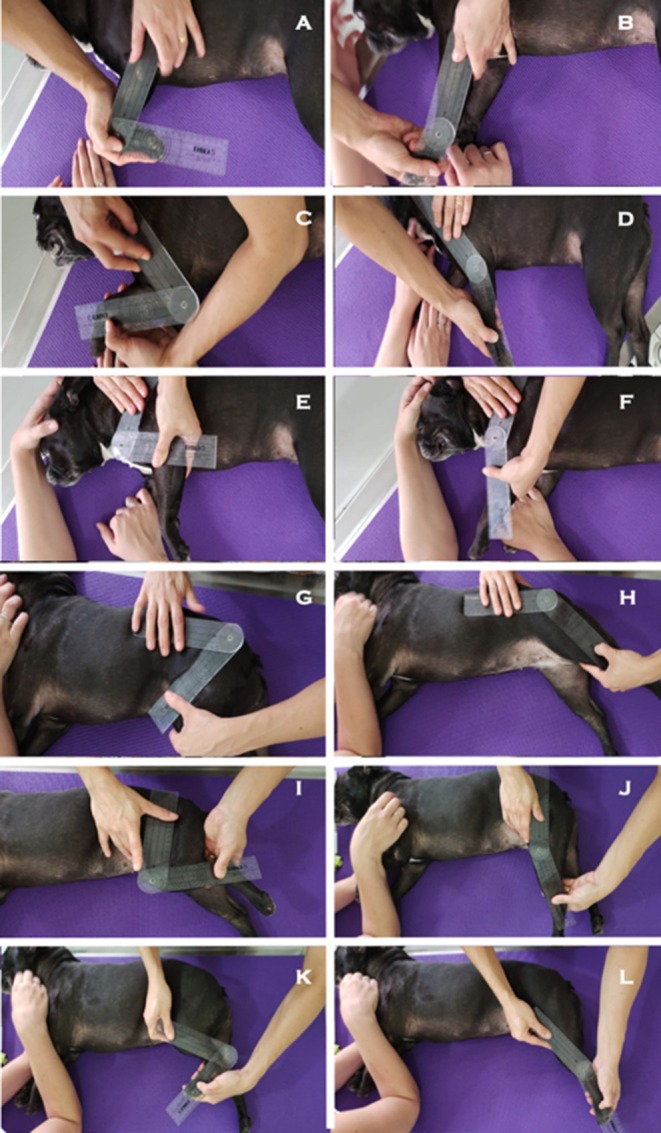
Correct goniometer positioning (A) carpal flexion; (B) carpal extension; (C) elbow flexion; (D) elbow extension; (E) shoulder flexion; (F) shoulder extension; (G) hip flexion; (H) hip extension; (I) stifle flexion; (J) stifle extension; (K) tarsal flexion; and (L) tarsal extension.